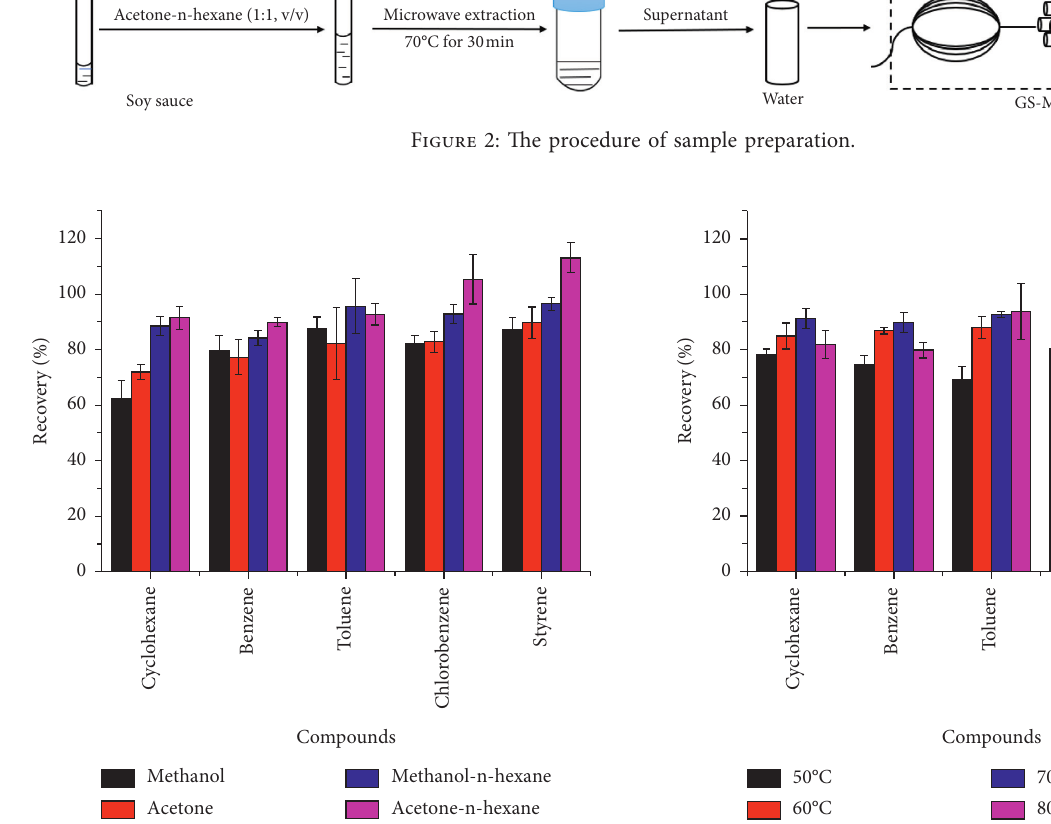
Figure 3: Effect of the type of extraction solvents on extraction efficiency of soy sauces.